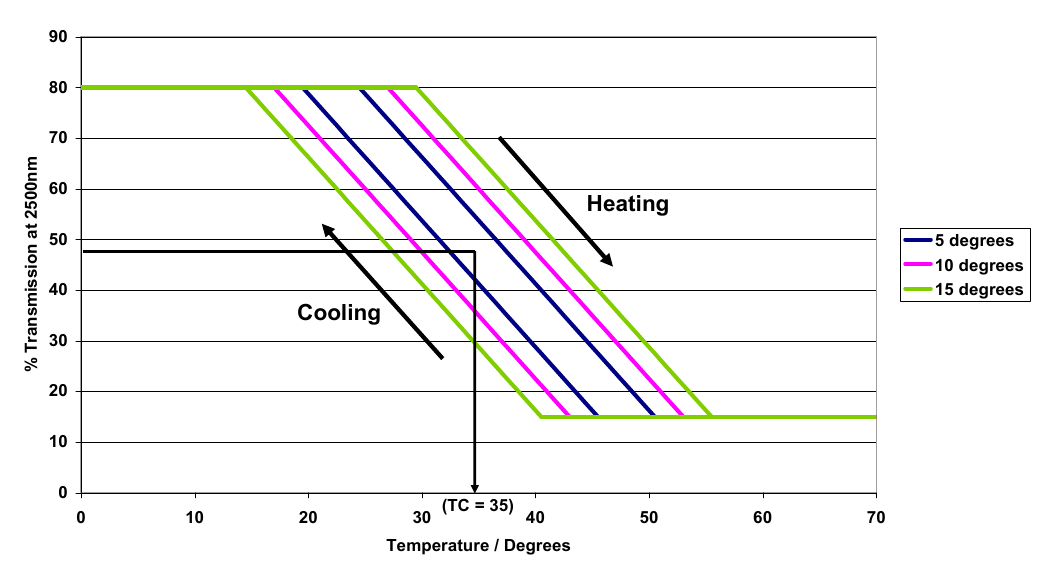
Figure 11. Diagram showing the theoretical hysteresis loops modeled for T c = 35 °C.